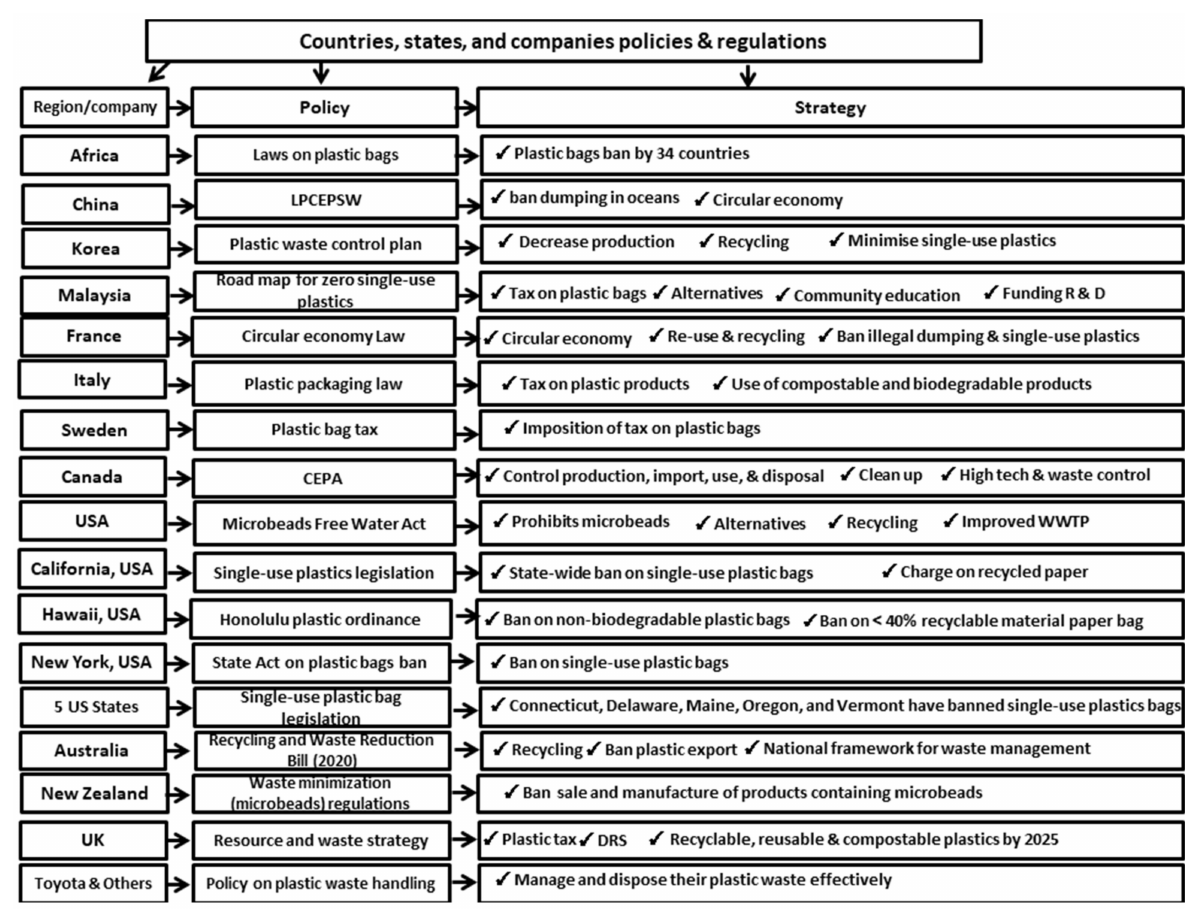
Figure 4. Countries, states, and companies strategies on plastics pollution control. Table 4. Policy and strategies by countries, states, companies and non-governmental